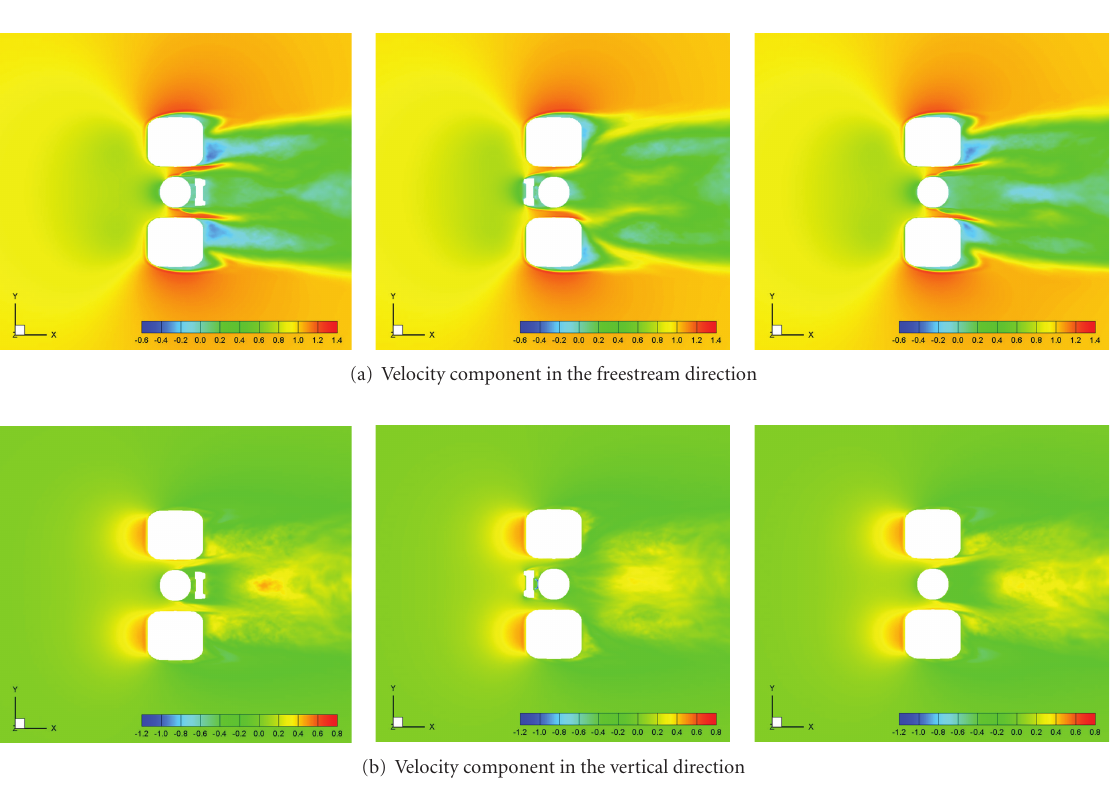
Figure 16: Computed mean velocity component at cross section z = − 1 . 81 (left: BACK TEAR, center: FRONT TEAR, right: NO